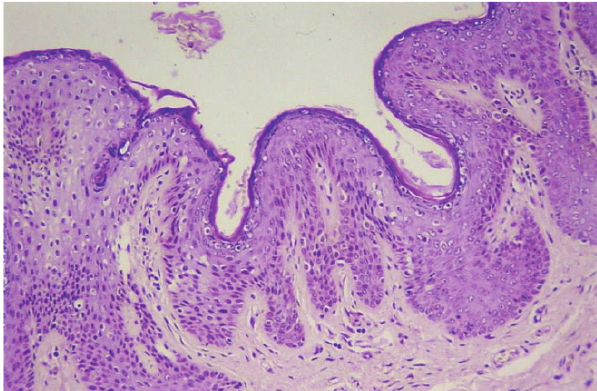
Figure 2 - The hyperplasia of the corneal extract can be seen in greater detail along with an increased number of keratinocytes, an increase of the papillary dermis, and an extension of the dermal papillae. These alterations are characteristics of acanthosis nigricans (hemotoxylin and eosin 50x)